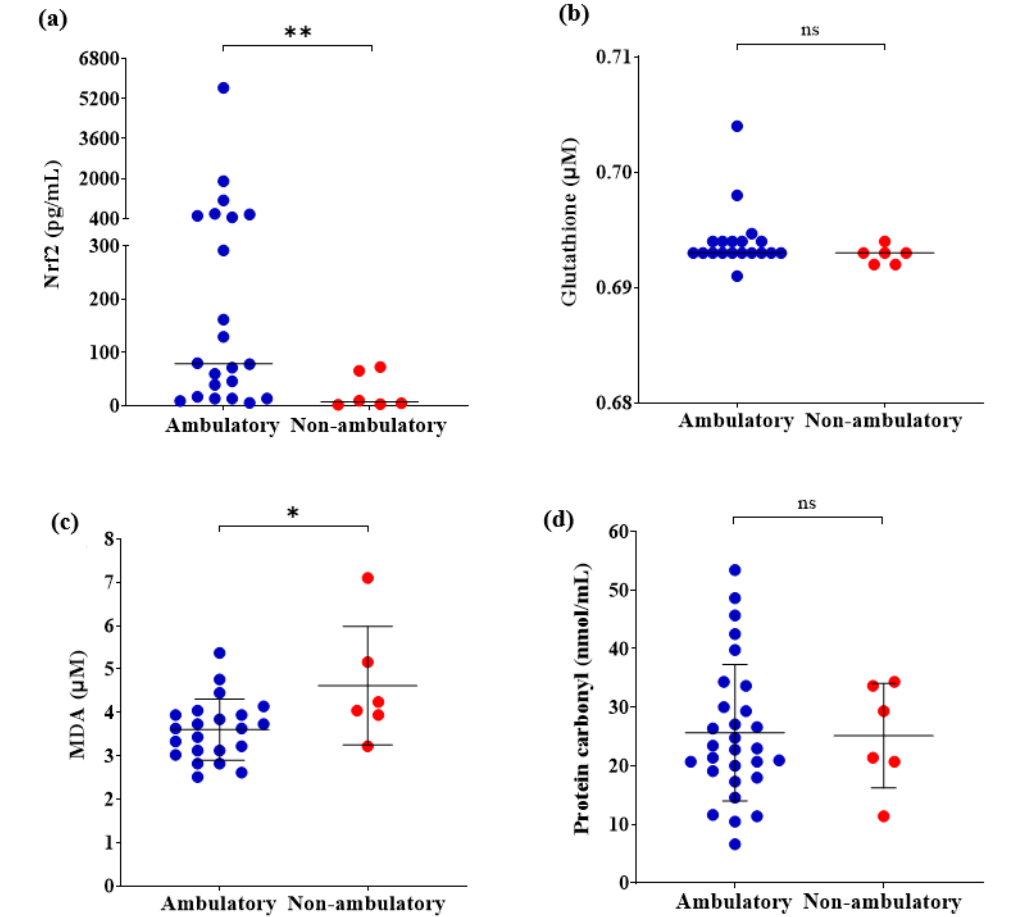
Figure 1. Comparison of circulating OS markers between ambulatory ( n = 22) and non-ambulatory ( n = 6) DMD patients. ( a ) Nrf2; ( b ) Glutathione ( n = 19, n = 6); ( c ) MDA; ( d ) Protein carbonyl. Student t -test or Mann-Whitney U -test according to data distribution. * p ≤ 0.05, ** p ≤ 0.01. OS, Oxidative stress; Nrf2, NFE2 like bZIP transcription factor 2; MDA, Malondialdehyde; ns, not significative.